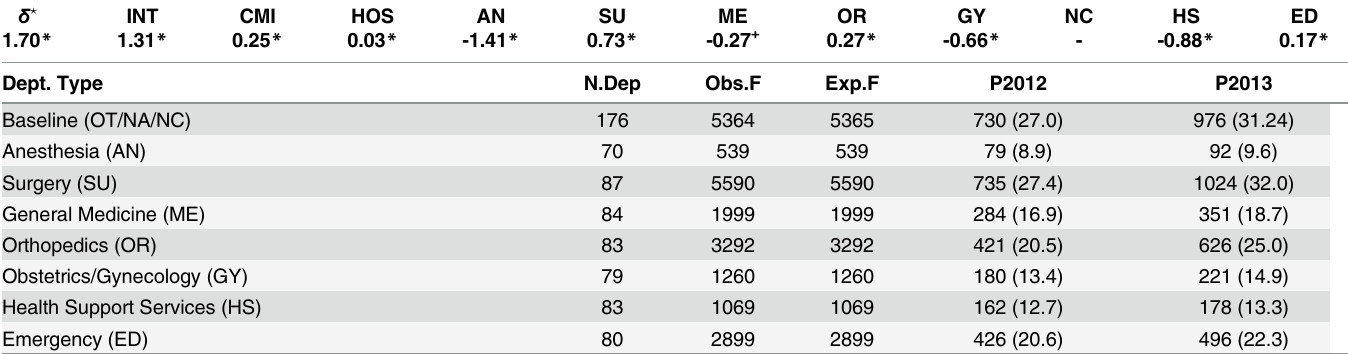
Table 5. Results for injuries, for all data pooled together (ALL). Estimates of the parameters of the Poisson model as per Appendix 2.1, number of depart- ments of a given type that generated each alleged type of claim (N.Dep), observed frequencies of claims for the different types of departments (Obs.F), expected frequencies according to the model (Exp.F), and predicted claims for 2012 (P2012) and 2013 (P2013), together with their standard deviations (in brackets).